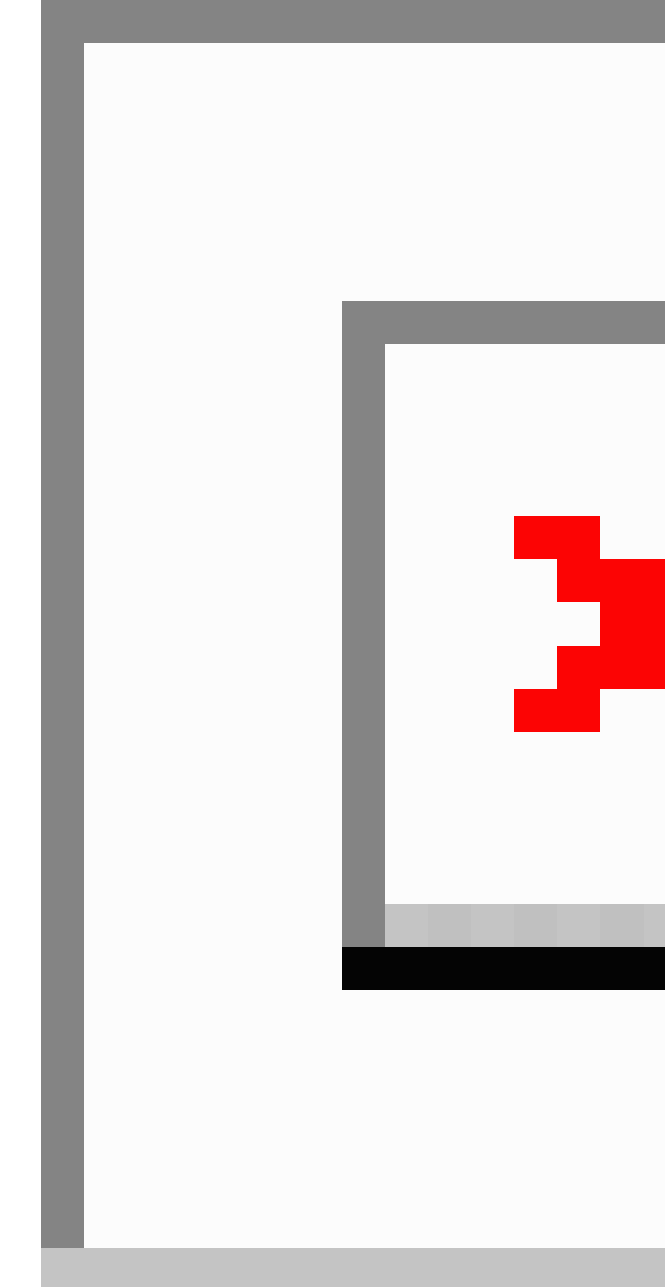
Table 1. Two wearable activity trackers’characteristics.